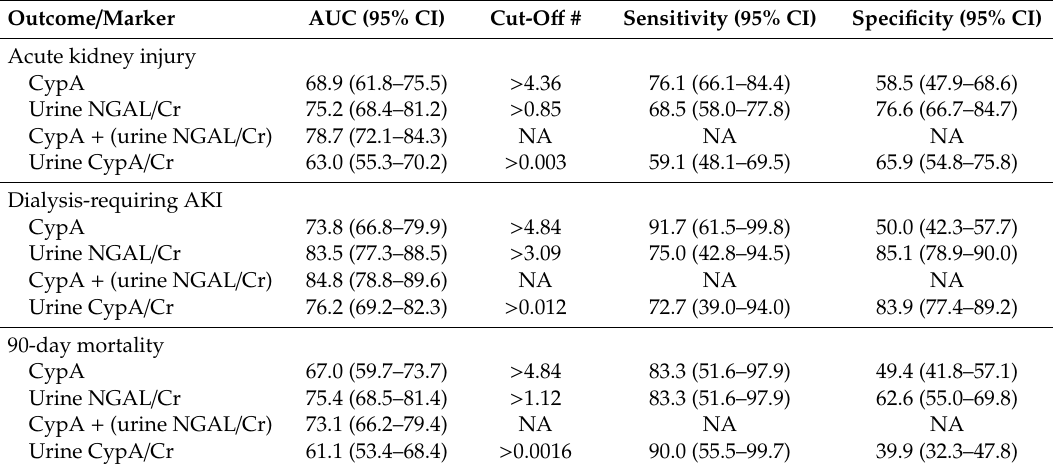
Table 3. Diagnostic property of markers in discriminating